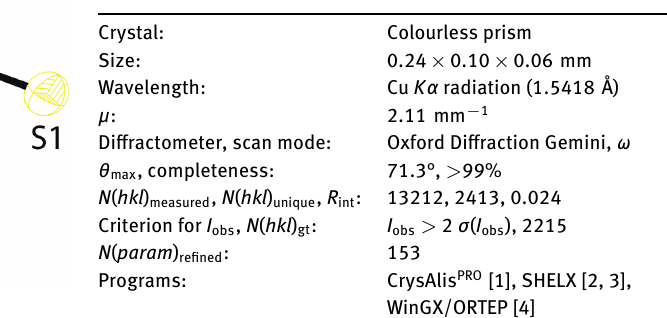
Table 1: Data collection and